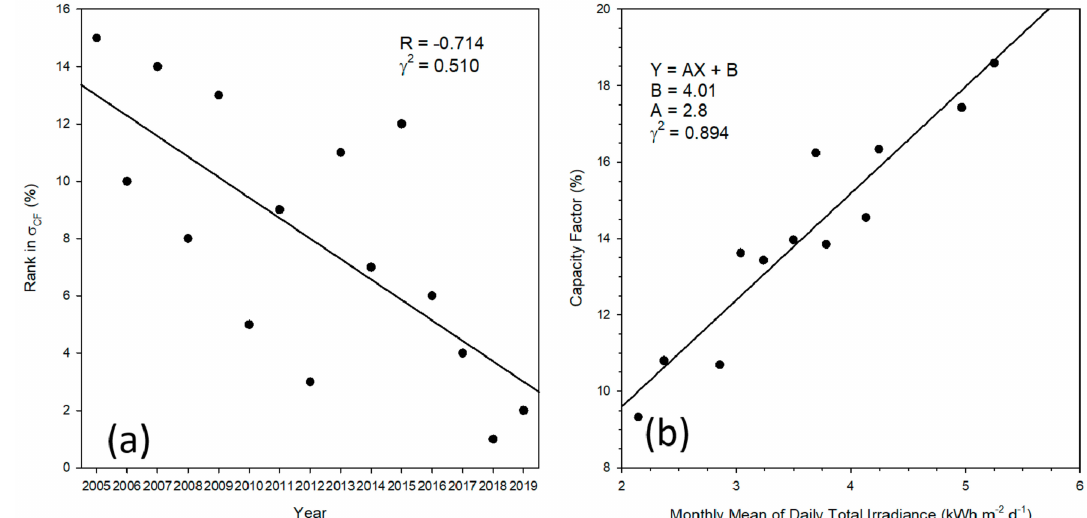
Figure 10. Scatter plots: ( a ) rank between year and σ CF (standard deviation) that is EPSIS data, ( b ) capacity factor and monthly mean of daily total irradiance that is output from the UASIBS–KIER model.